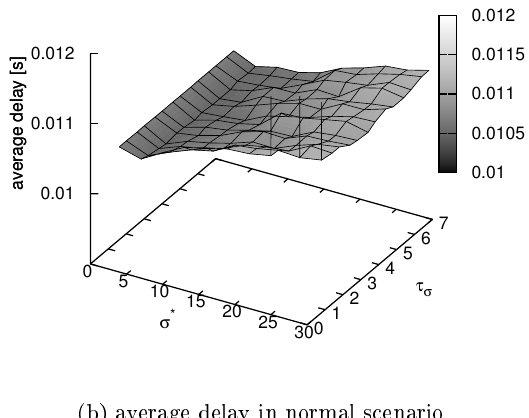
Figure 4: the evaluation of average delay for values of σ (cid:3) and τ σ